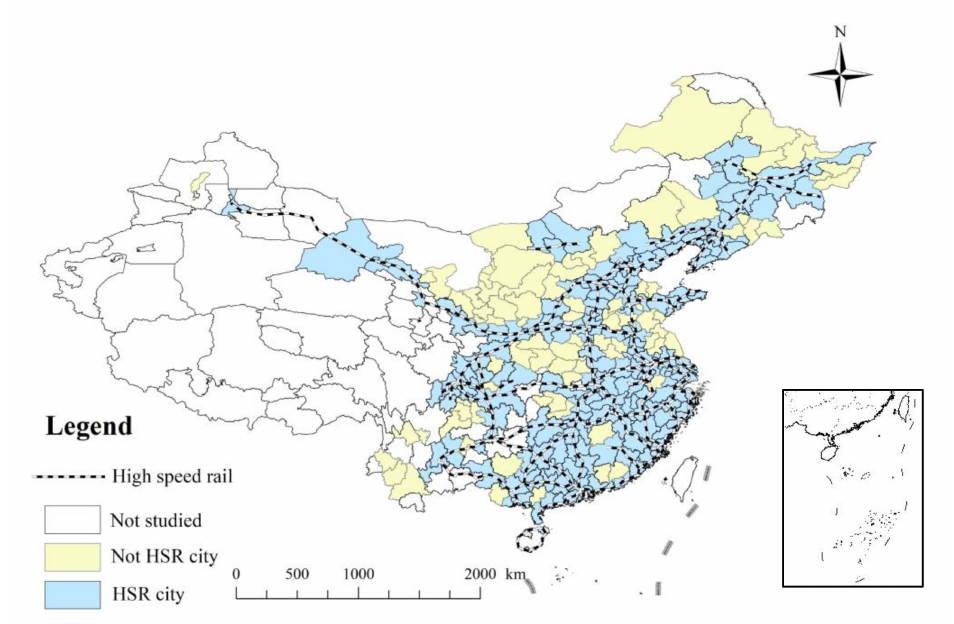
Figure 2. Construction and operation of China’s major HSR in